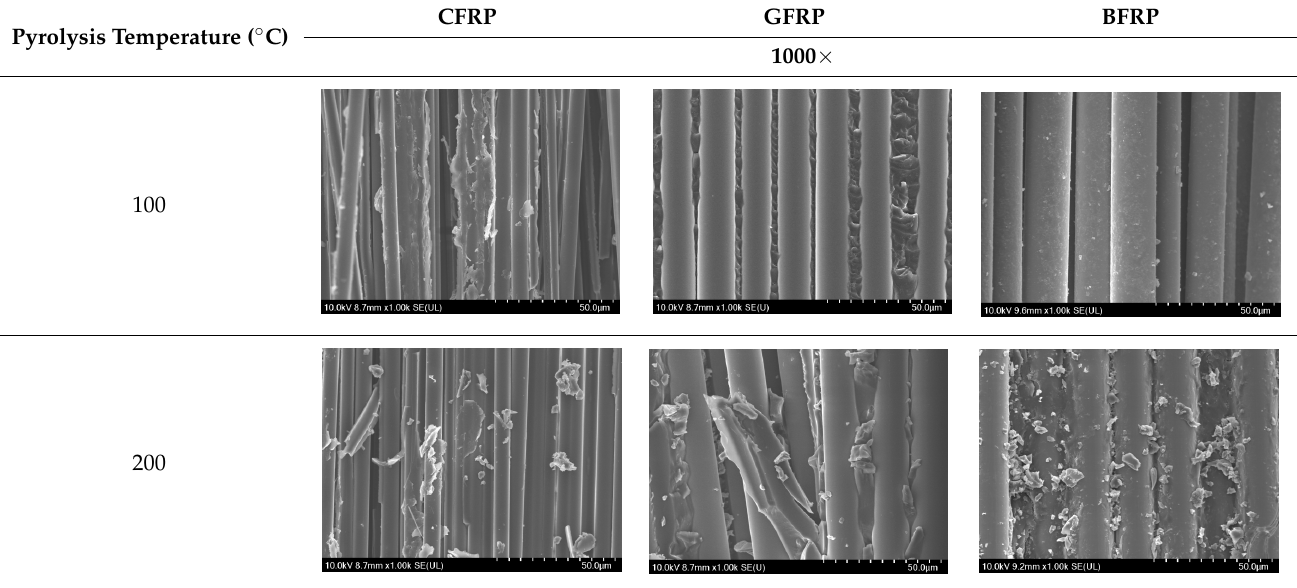
Table 4. Surface morphology of CFRP, GFRP, and BFRP according to pyrolysis temperature (1000×).